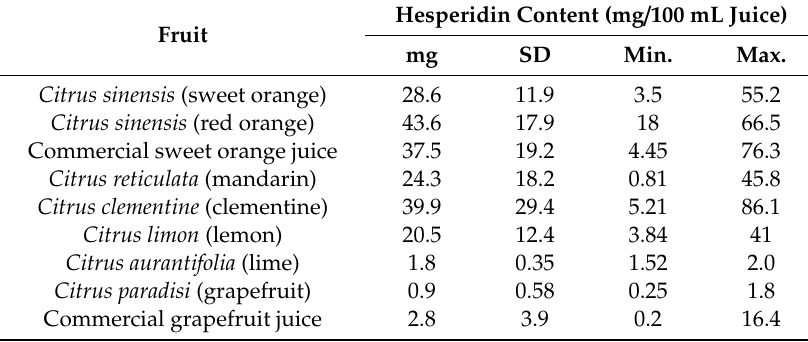
Table 1. Hesperidin content (mg / 100 mL of fresh juice) in di ff erent citrus fruits. Data are from the reviews of Gattuso et al. [22] and, for red orange, of Grosso et al. [23] Hesperidin Content (mg / 100 mL Juice) Fruit mg SD Min. Max. Citrus sinensis (sweet orange) 28.6 11.9 55.2 Citrus sinensis (red orange) 66.5 Commercial sweet orange juice